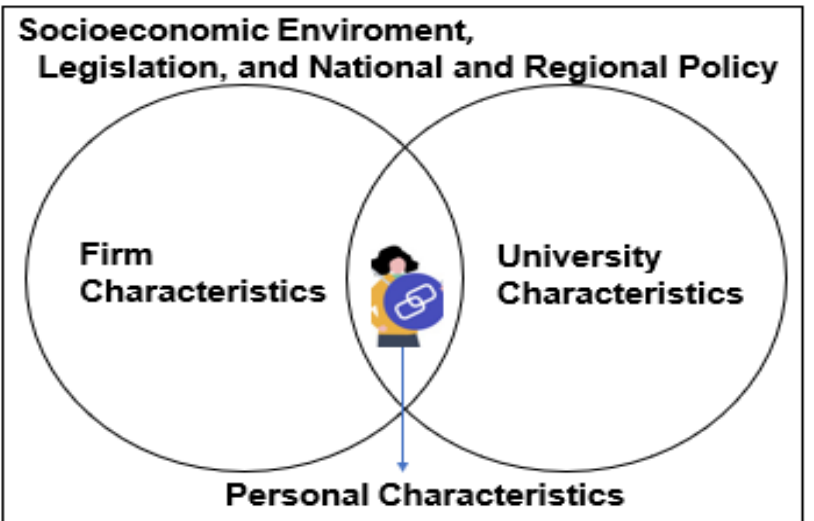
Figure 4. Context of university–industry collaborations.